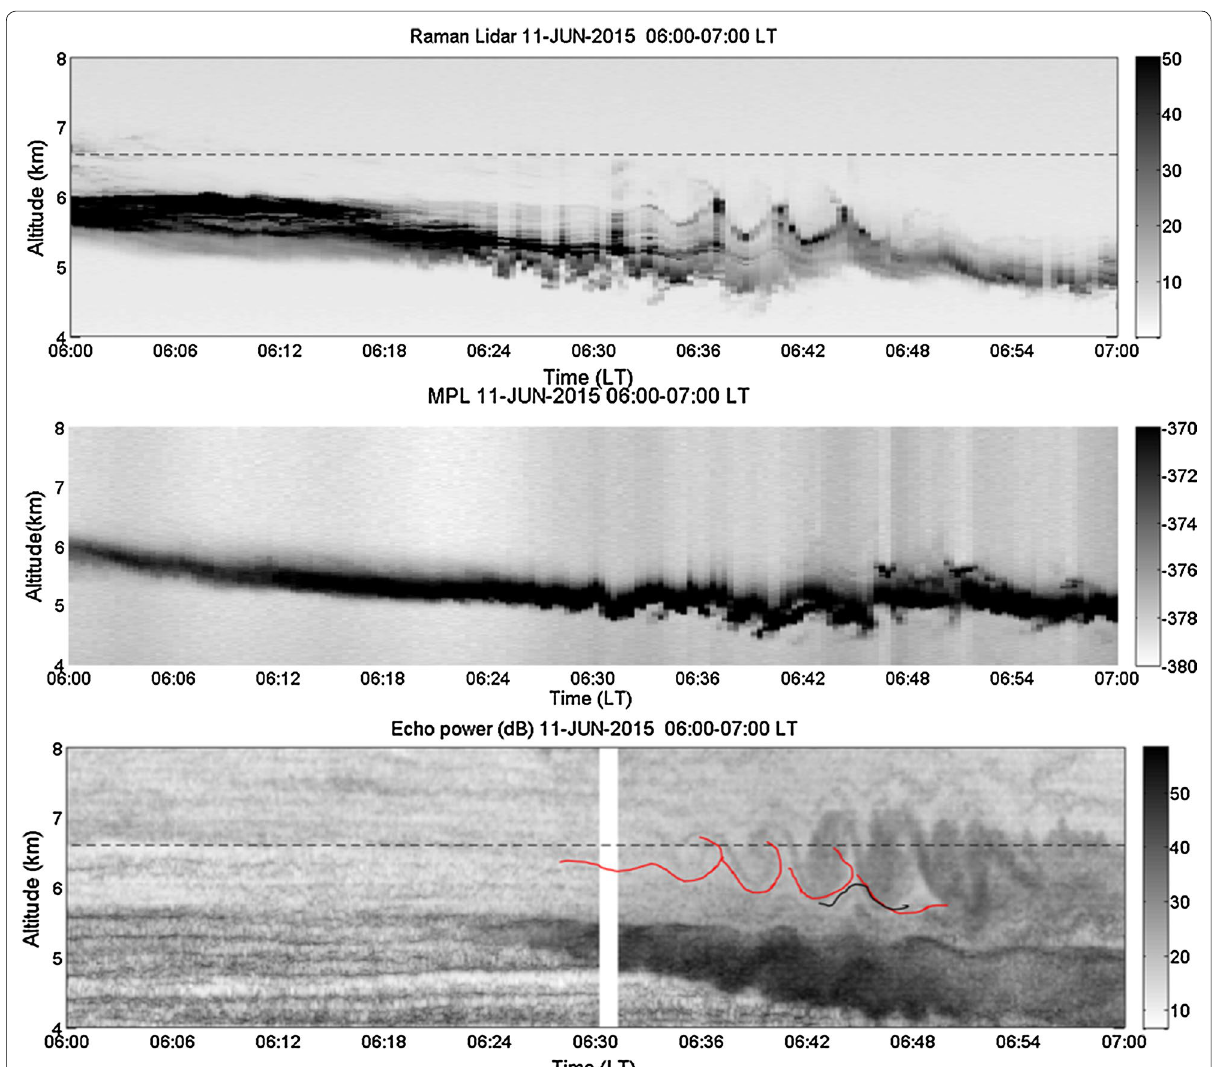
Fig. 7 Time–height cross section of relative backscatter signals (arbitrary units) of RRM lidar (top) and MPL (middle), and MU radar echo power at vertical incidence (bottom) from 0600 LT to 0700 LT and in the height range (4–8 km). The dashed line (top and bottom) shows the mean altitude of the KH billows. The thin and short black (red) lines in the bottom panel outline the RRM lidar and MPL signals in relation to the KH billows. The black line is shifted by 80 s with respect to the time shown in the middle panel, and the red line is moved up by +